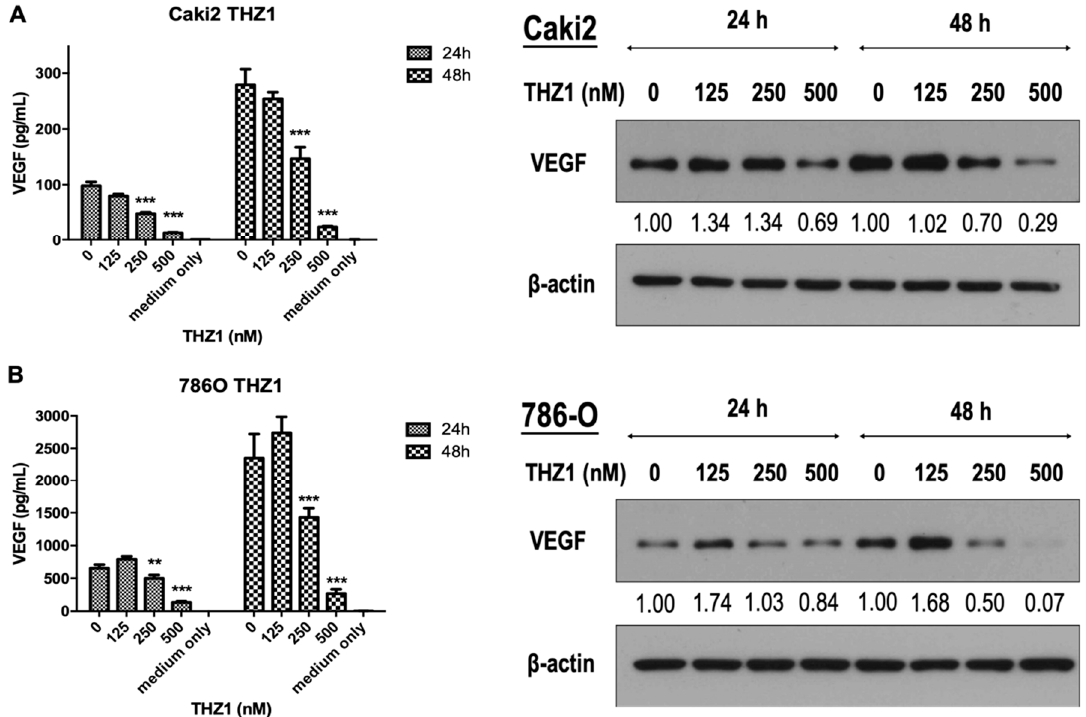
Figure 5. THZ1 dose-dependently inhibited VEGF secretion and expression in Caki-2 and 786-O cells. ( A ) Caki2 and ( B ) 786-O cells were treated with various concentrations of THZ1 (125, 250, and 500 nM) for 24 and 48 h. After treatment, the conditioned media were collected for determining VEGF secretion using enzyme-linked immunosorbent assay (ELISA), and the cell lysates were subjected for VEGF expression analysis by Western blotting using antibody against human VEGF. ** p < 0.01 and *** p < 0.001 compared to the control group (DMSO). Numbers under the plots indicate the fold change of protein level relative to their control. Similar results have been obtained in two independent experiments.